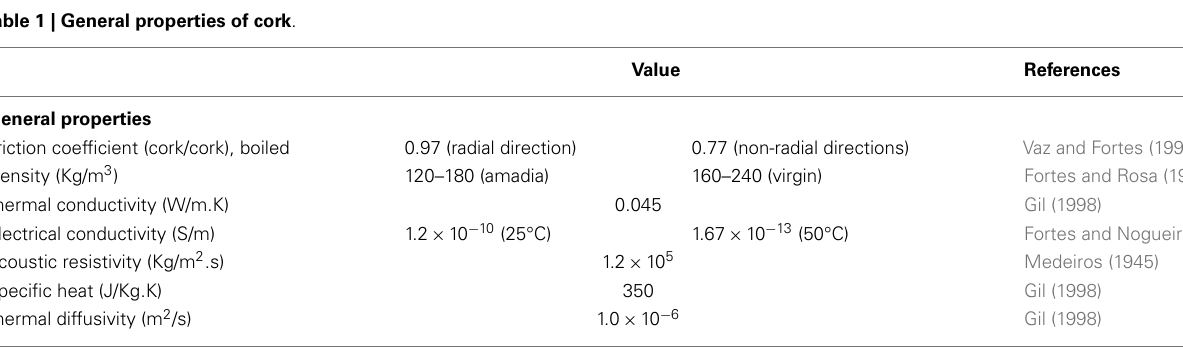
Table 1 | General properties of cork .